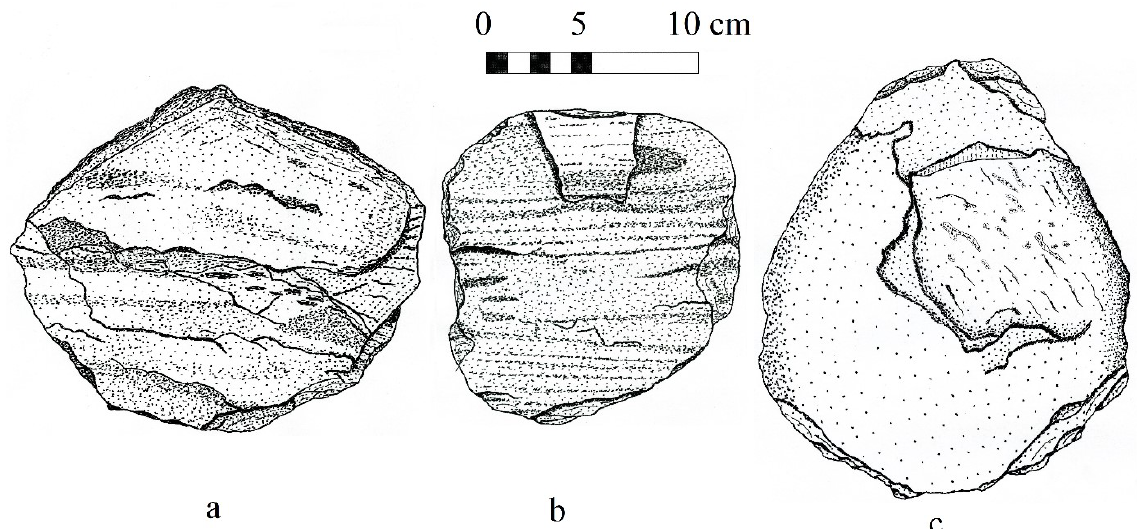
Figure 1. Disc and Ovate-shaped tools. (a) Specimen 19, a disc-shaped tool with natural intersecting flat surface backing, working edge pointed downward (see Figure 3). (b) Specimen 14. An ovate-shaped (originally sub- rectangular?) tool with an asymmetrical working edge. (c) Specimen 6, an ovate-shaped tool with working edges on both ends (seeFigure 7). (Drawings by Steve Tomka.)